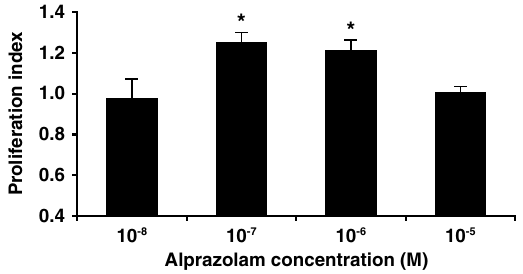
Figure 3. Alprazolam enhances human islet cell replication. Fresh human islets were treated in triplicate with the indicated dosage of GABA, together with, or without, the indicated PAM as described in Methods. Data shown are the average rate of proliferation relative to that of cultures with medium alone (designated as 1). N = three independent studies. * p < 0.05, determined by Student T